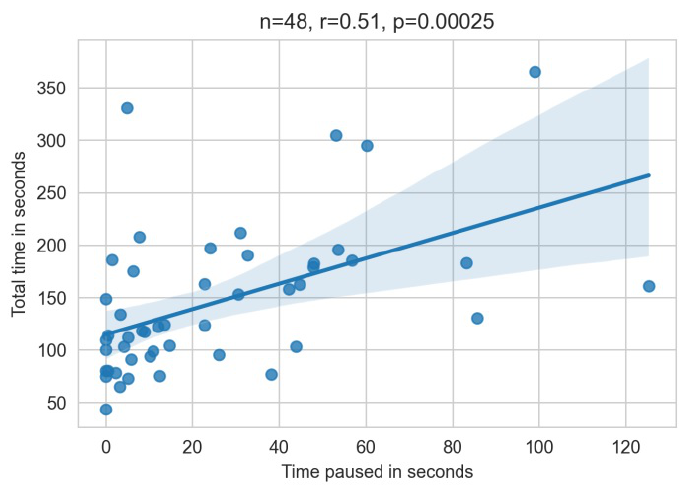
Figure 10. Pearson correlation of the pause time during reading and the total time. Statistics indicated in the